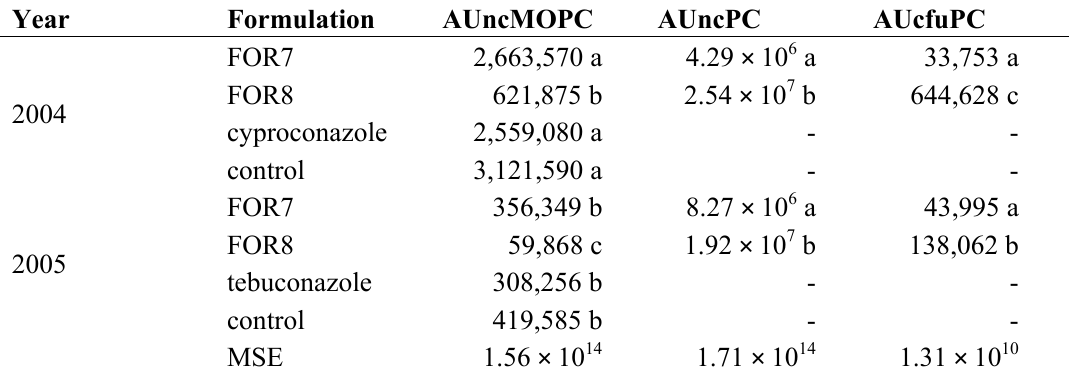
Table 2. Effect of the Epicoccum nigrum (FOR7) and Penicillium frequentans (FOR8) conidial formulations on the area under progress curve for the number of conidia of Monilinia spp. (AUncMOPC) and the number of E. nigrum or P. frequentans conidia (AUncPC), and the area under progress curve for the number of colony-forming units (CFU) of E. nigrum or P. frequentans (AUcfuPC) for the surfaces of “Autumn Free” nectarines from a commercial orchard in Sudanell, Spain in 2004 and